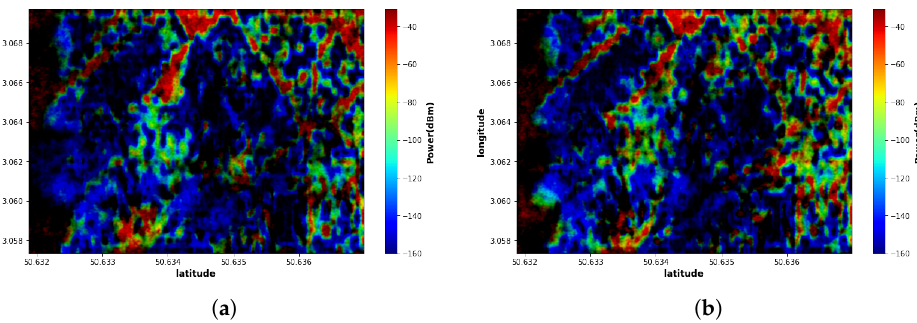
Figure 7. EMGAN-based reconstructed maps when different numbers of sensors are considered: ( a ) Using 15 sensor maps; ( b ) Using 30 sensor maps.